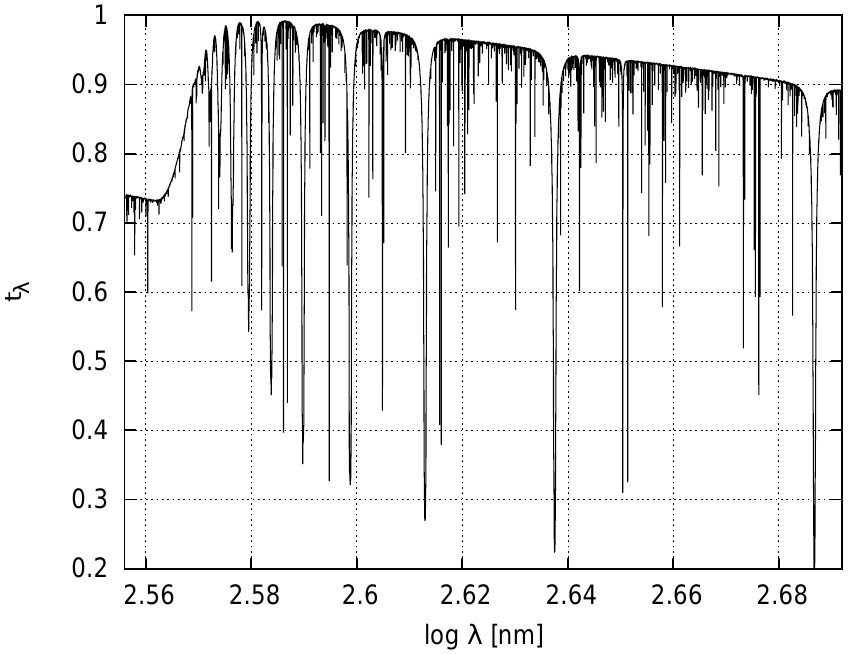
Fig. 1. The model spectrum ( T eff = 16 000 K, log g = 4) in the region of the Balmer lines. The abscissa is log (cid:21) [nm] and the ordinate is the reduced temperature t (cid:21) , which corresponds to the black-body